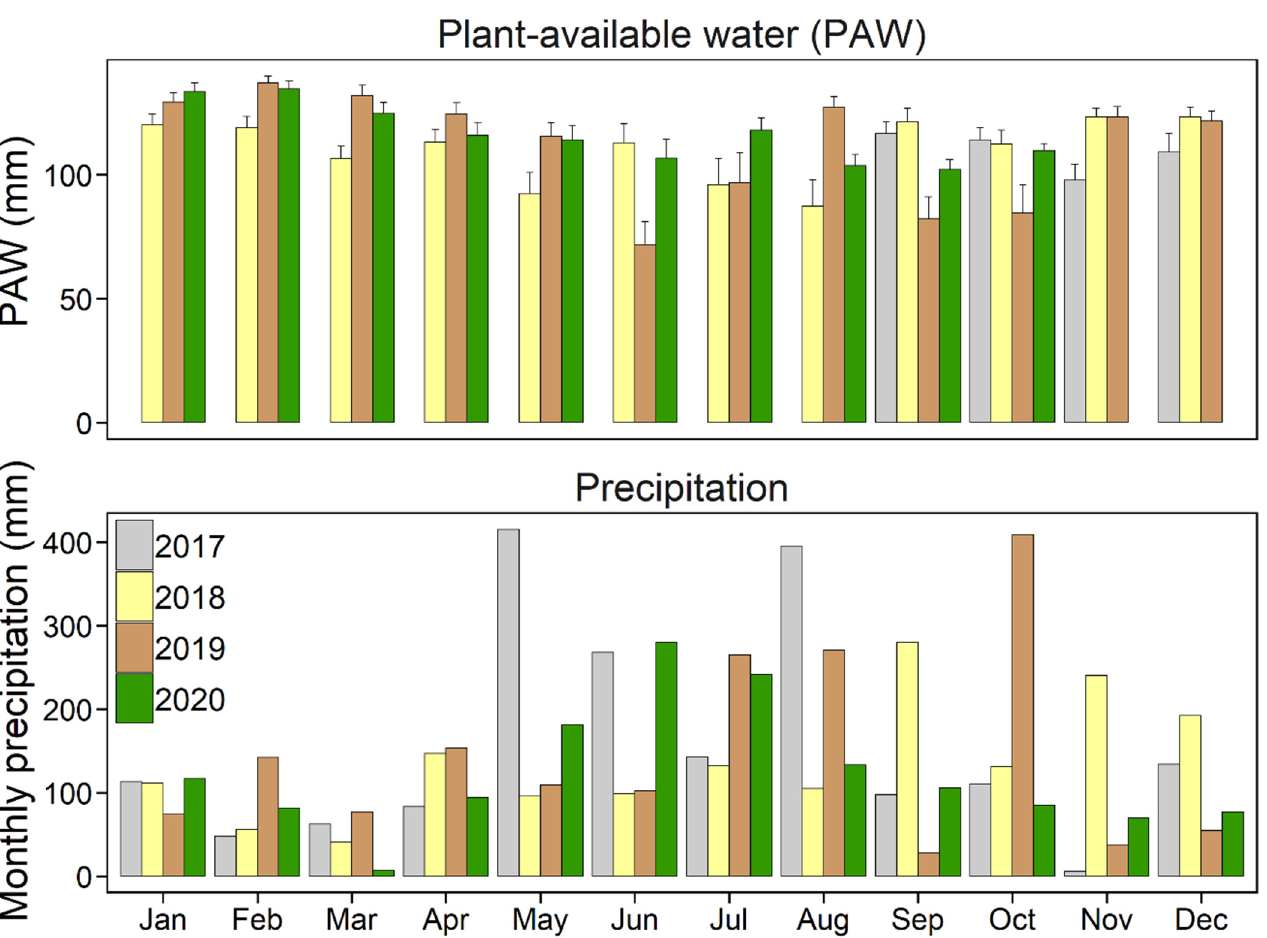
Figure 2. Precipitation (mm) and plant-available water (mm; PAW) monthly through the experiment from 2017 to 2020. Precipitation is the sum of rain monthly, and PAW is the sum of average daily PAW for the three depths (15, 30, 45 cm). Total annual precipitation for 2017–2020 was 1875, 1614, 1720, and 1477 mm, respectively. Table 1. Soil characteristics with depth in plots separated by row spacing and sugarcane varieties. Volumetric water content (VWC), plant-available water (PAW; mm), and soil temperature were measured at soil depths of 15, 30, and 45 cm in 15-min intervals from September 2017 until Septem- ber 2020. Daily means were calculated for VWC, PAW, and T, and the values here represent the mean daily value over the study.